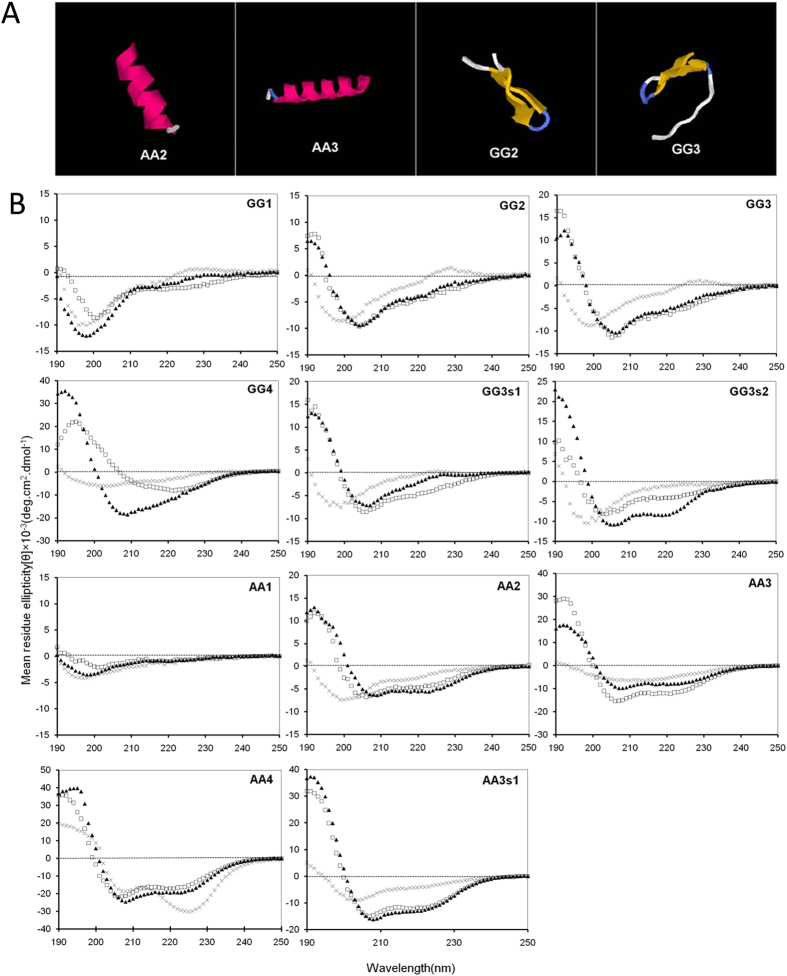
(A) Three-dimensional structure projections of AA2, AA3, GG2 and GG3. (B) The CD spectra of all peptides. All peptides were dissolved in 10 mM PBS (pH 7.4) (×), 50% TFE (□), or 30 mM SDS (▲). The mean residue ellipticity was plotted against wavelength. The values from three scans were averaged per sample, and the peptide concentrations were fixed at 150  μM.